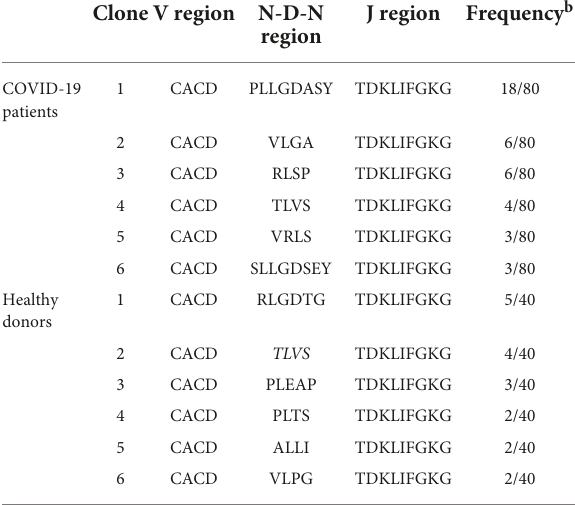
TABLE 2 Deduced V γ 9 CDR3 amino acid sequences of COVID-19 patients and healthy donors a . Clone V region N/P J region region